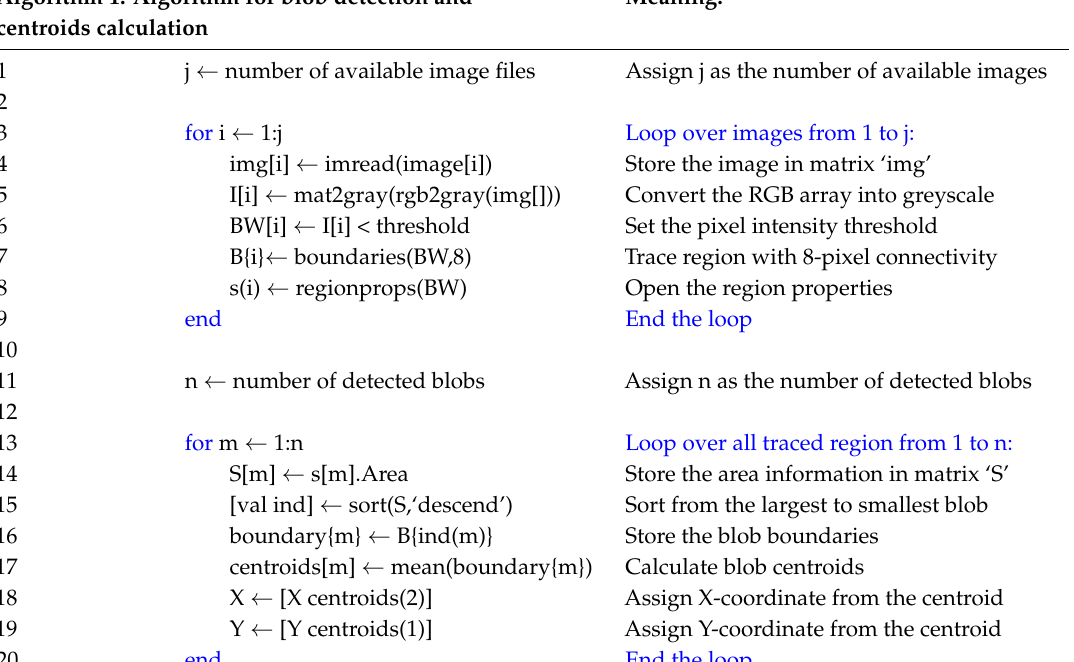
Algorithm 1: Algorithm for blob detection and centroids